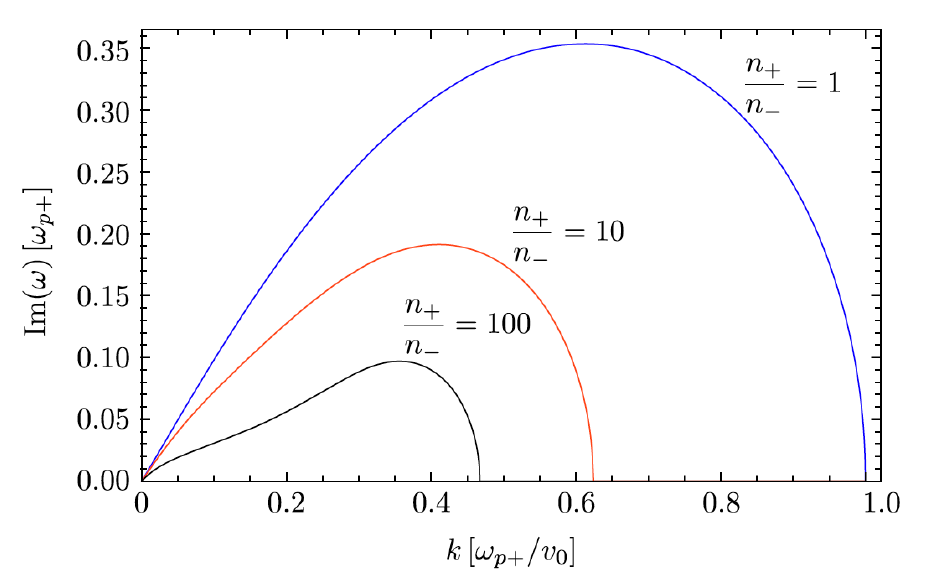
Figure 1. Growth rate Im ( ω ) of unstable kinetic Kelvin-Helmholtz modes in an electron-proton plasma following linear theory for a microscopic tangential shear flow with step-functional velocity jump across the x = 0 plane, corresponding to two counter-propagating flows with speed v 0 and different densities n + (for the flow in the upper region x > 0) and n − (for the flow in the lower region x < 0). The curves shown are for a density contrast n + / n − = 1,10,100, respectively. The growth rates display a cut-off at k ≤ 1 (in units of ω p + / [ v 0 γ 0 ] , where ω p + = [ 4 π n + e 2 / γ 0 m e ] 1/2 ), and take on a maximum value somewhat below. The three curves qualitatively resemble each other, but with a growth rate that is lowered for n + / n − > 1. Note, however, that the results of linear fluid theory do not predict a growth of a DC ( k = 0) mode as found in PIC simulations (see below). From Ref. [62].